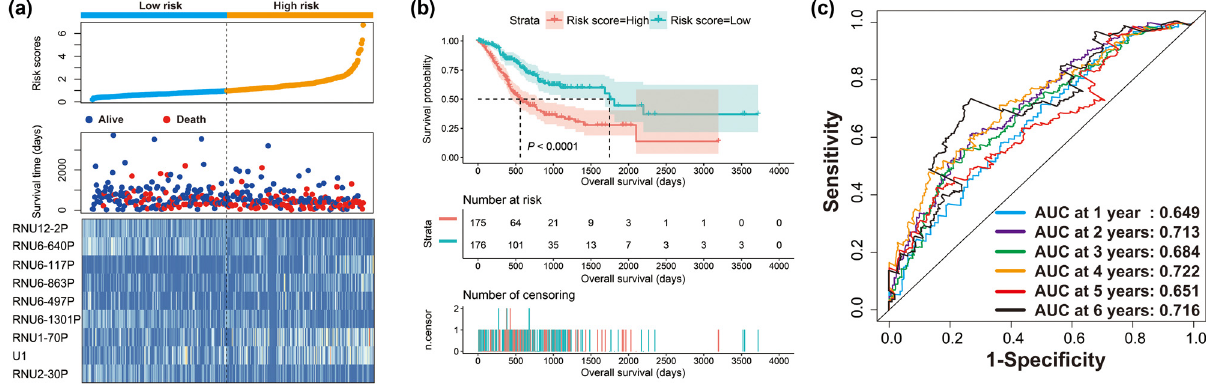
Figure 2: Prognostic value of this prognostic signature containing nine snRNAs: ( a ) risk score and survival time distribution plot; ( b ) Kaplan – Meier curve of the risk score in GC; ( c ) SurvivalROC curve of the risk score in